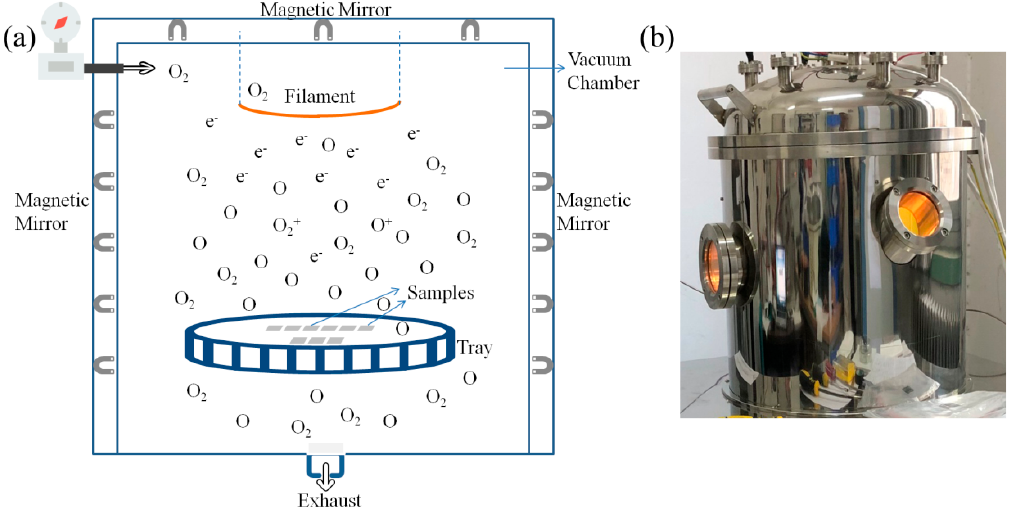
Figure 3. ( a ) the schematic of AO exposure experiment; ( b ) the ground-based AO effects simulation facility.